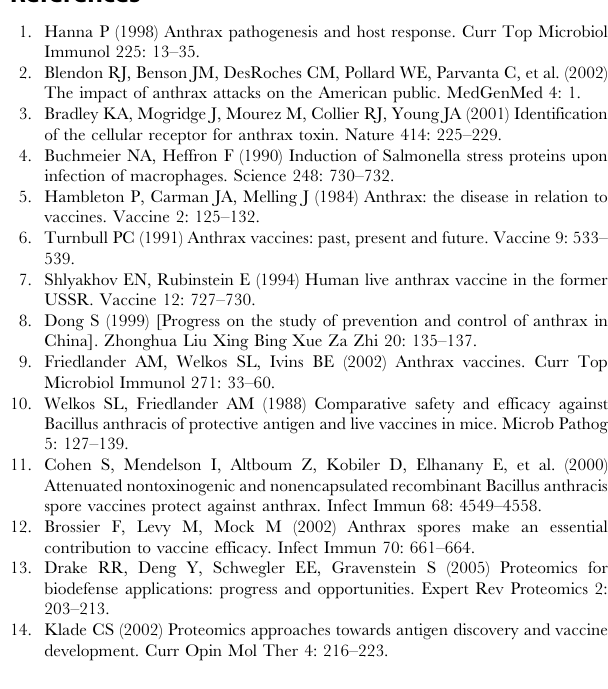
Table S4 The computational analyses of the novel immunogenic proteins identified in this